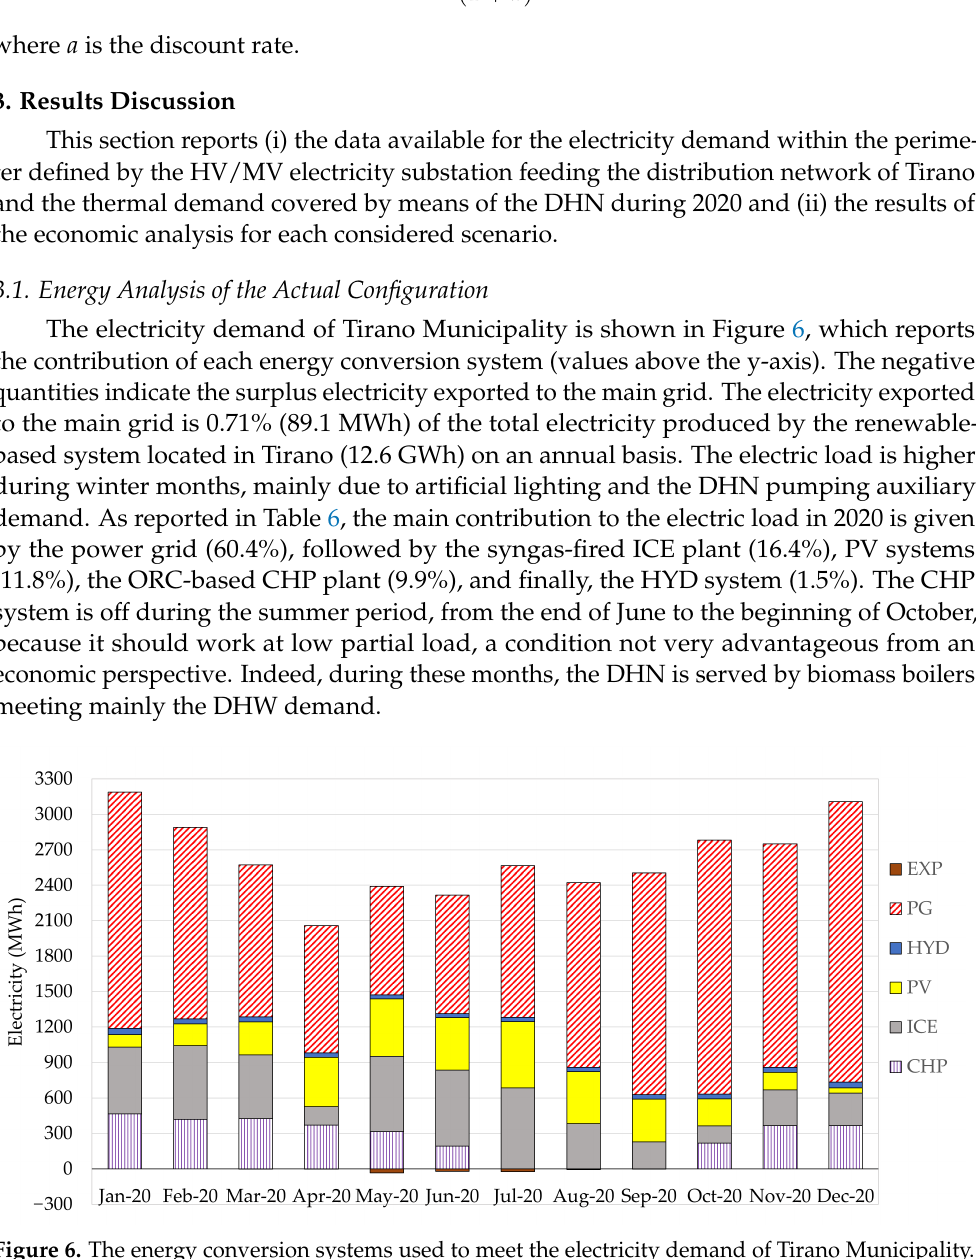
Figure 6. The energy conversion systems used to meet the electricity demand of Tirano Municipality. Table 6. Electric energy provided by the energy conversion systems serving the Municipality of